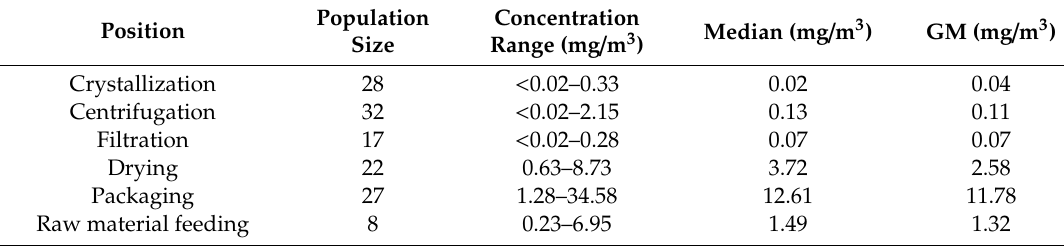
Table 2. Time-weighted average (TWA) values of subjects exposed to glyphosate (GLY) per position.